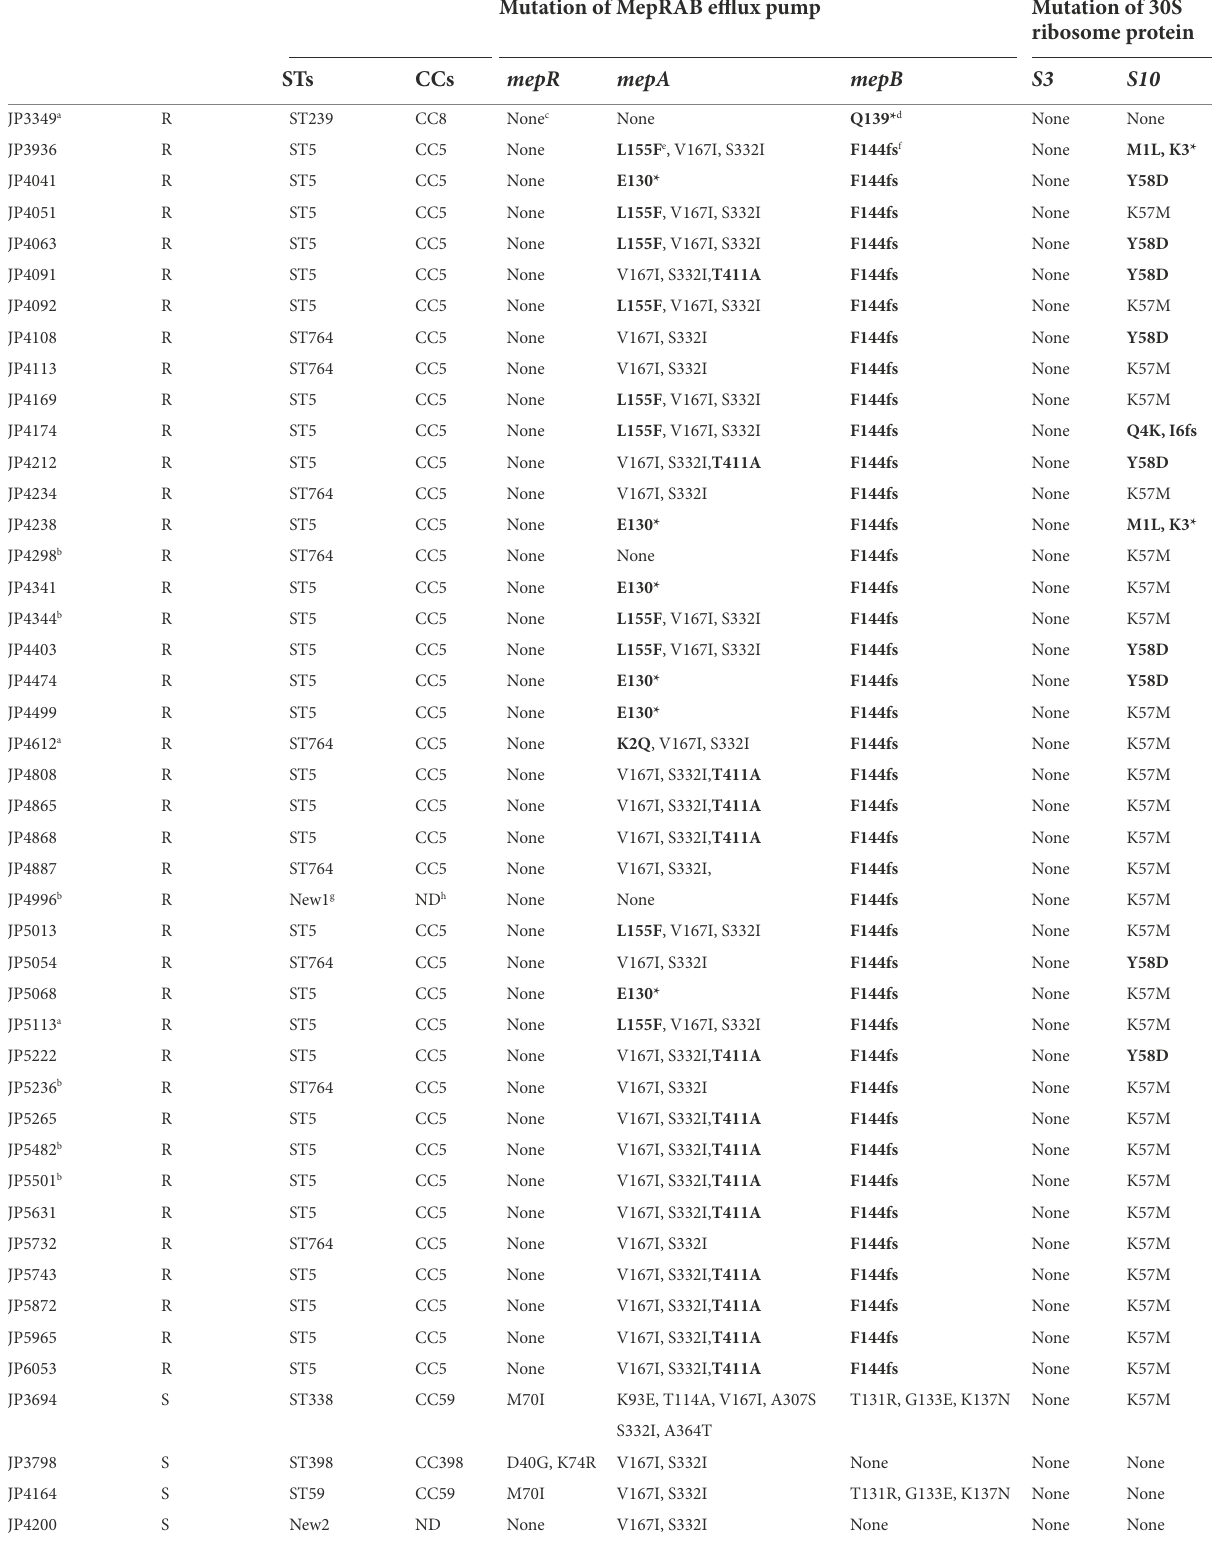
TABLE 4 Multi-locus sequence typing and the resistance mechanisms in tetracyclines-resistant and-susceptible Staphylococcus aureus. Isolates Type